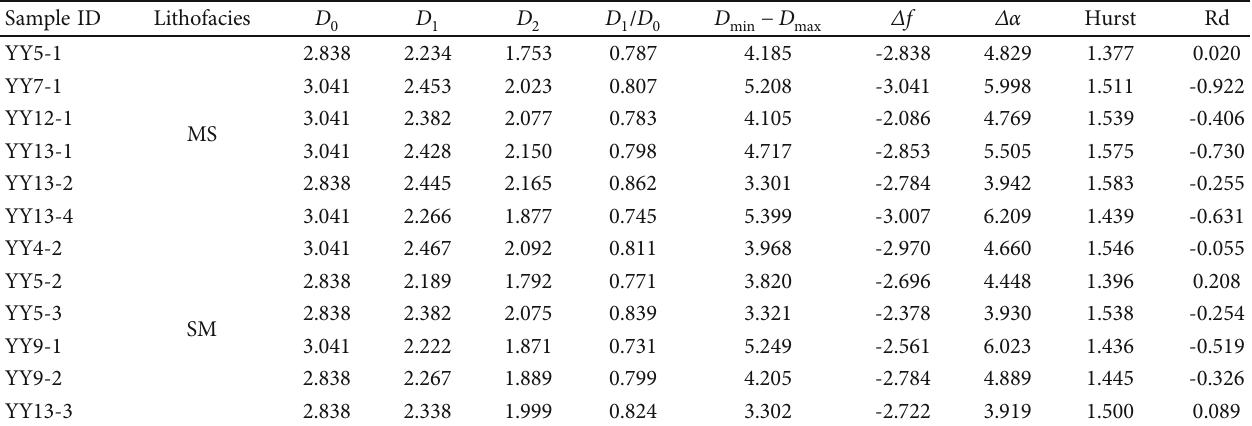
adsorption data. 2